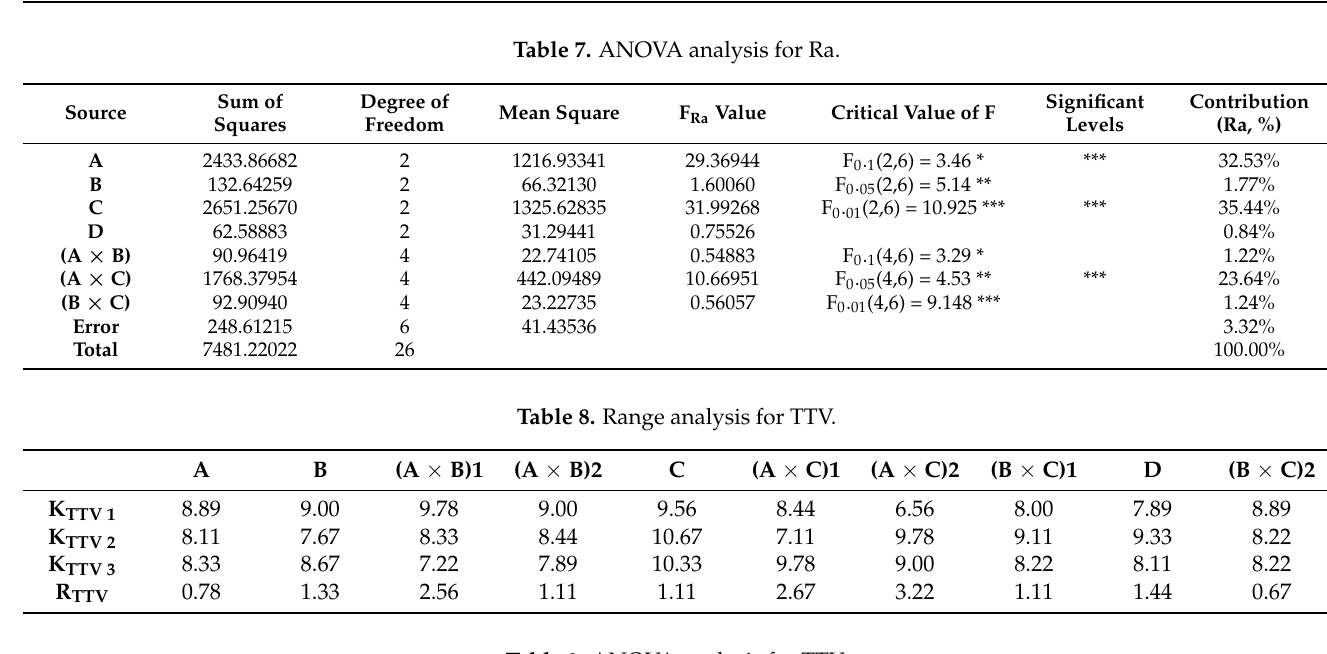
Table 9. ANOVA analysis for